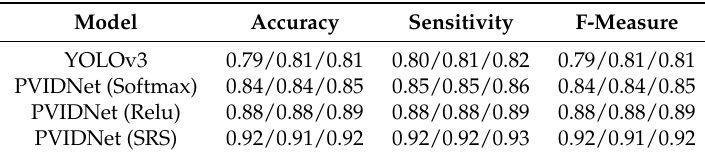
Table 15. Results of the DL algorithms to classify the images of regular cars (right/left/front) in the testing phase.